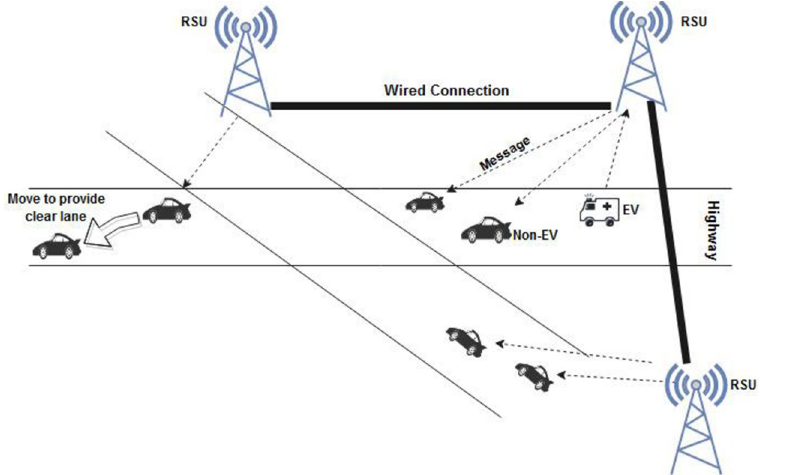
Fig 4. Communication over a MIPv6 based network.